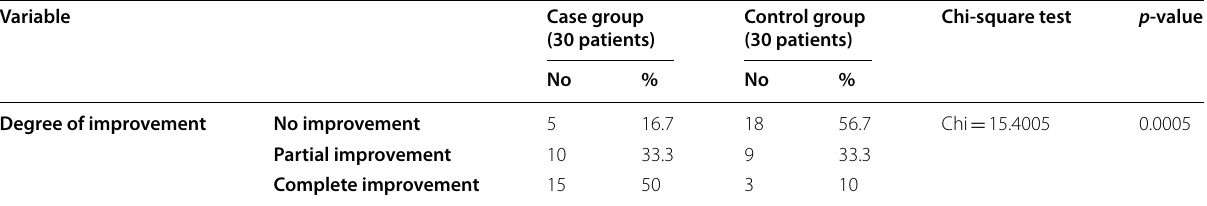
Table 3 Comparison between both groups regarding the degree of improvement of parosmia Variable